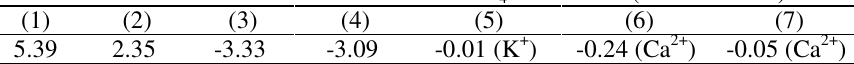
Table 3. Results of chemical reactions in B